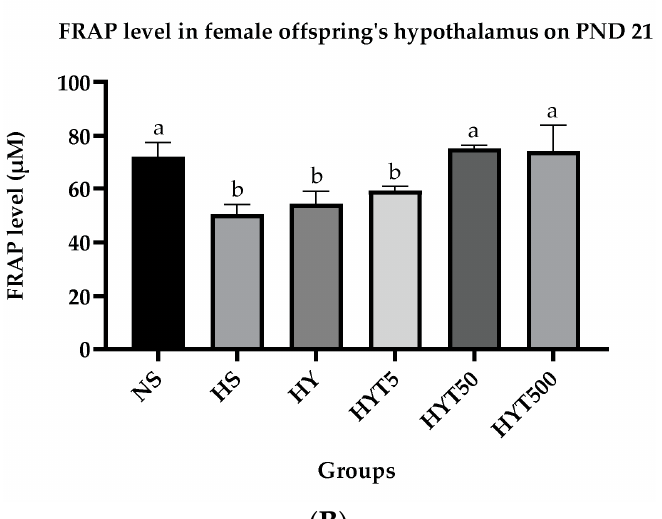
Figure 8. ( A ). Serum FRAP level in female offspring on PND 21. ( B ). FRAP level in hypothalamus of female offspring on PND 21. NS: normal chow and saline; HS: HFD and saline; HY: HFD and yoghurt; HYT5: HFD and 5 mg/kg of E. tapos yoghurt; HYT50: HFD and 50 mg/kg of E. tapos yoghurt; HYT500: HFD and 500 mg/kg of E. tapos yoghurt. Values are expressed as mean ± SEM. Different letters indicate a significant difference at p < 0.05.